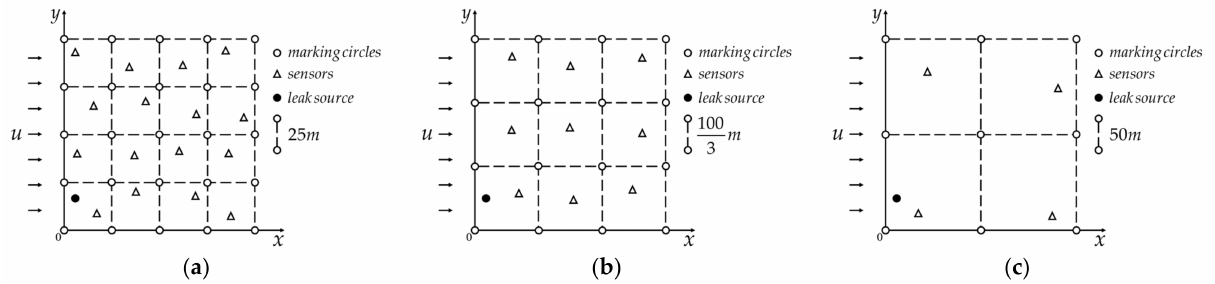
Figure 5. Schematic diagram of three application examples. ( a ) Distribution of 16 monitoring points and leak source; ( b ) distribution of 9 monitoring points and leak source; ( c ) distribution of 4 monitoring points and leak